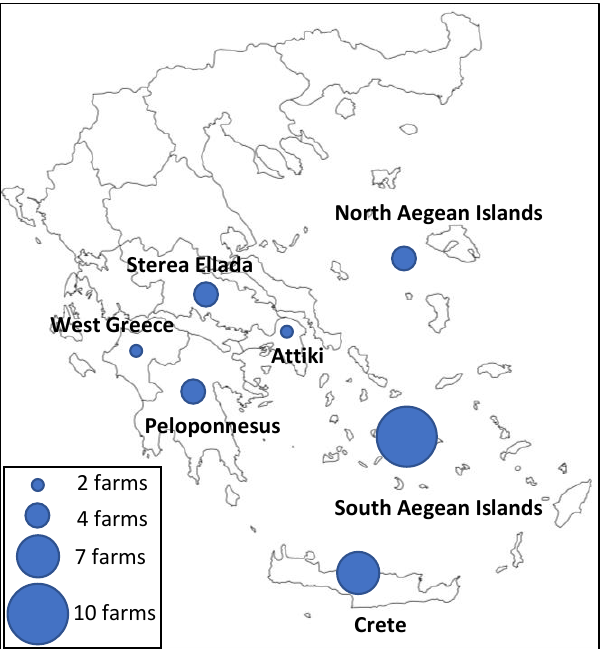
Figure 2. Location and distribution of the aloe vera farms in the sample (source: own elaboration).